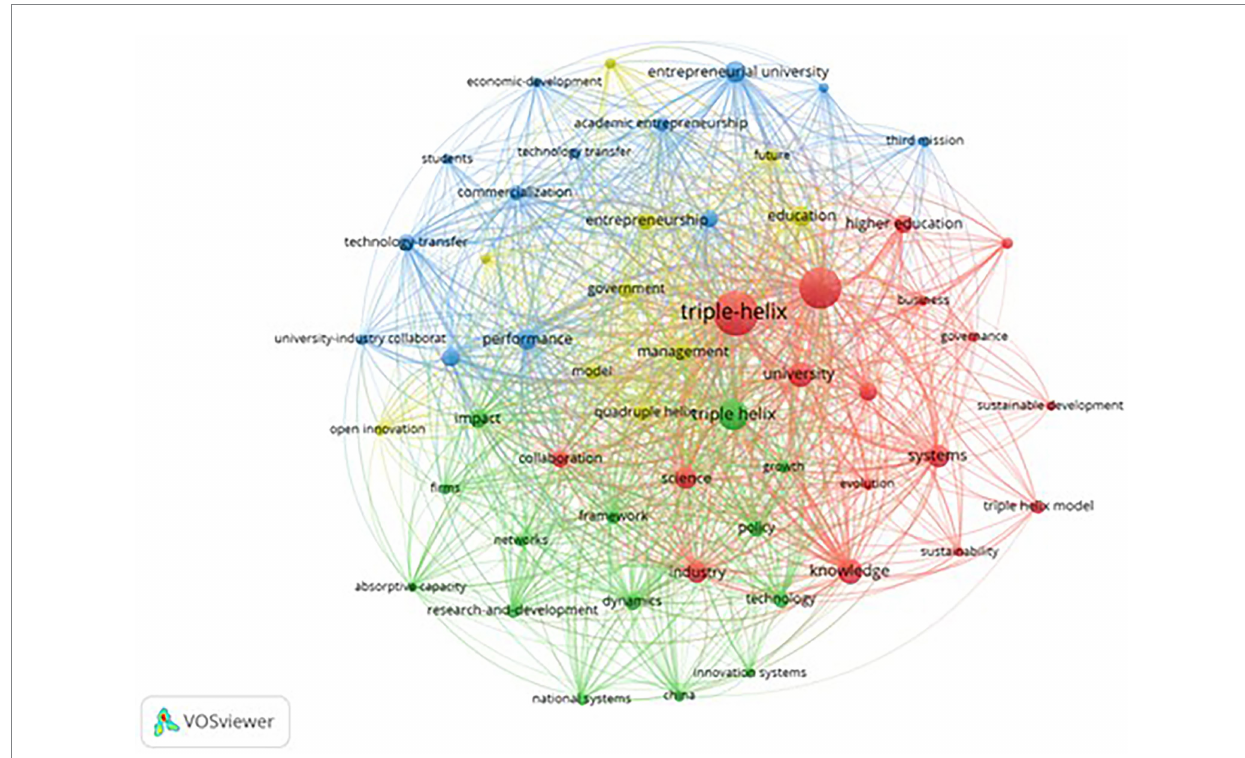
FIGURE 5 Co-word analysis of helix model and